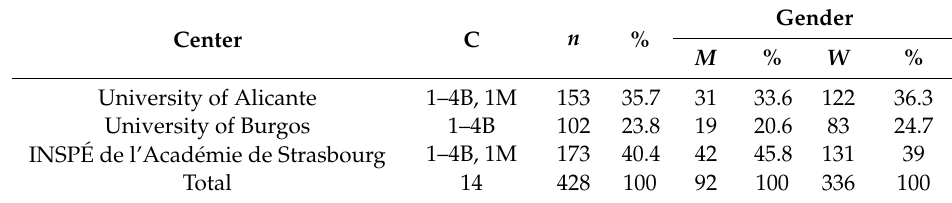
Table 2. Descriptive results (frequencies and percentages) by university institution and